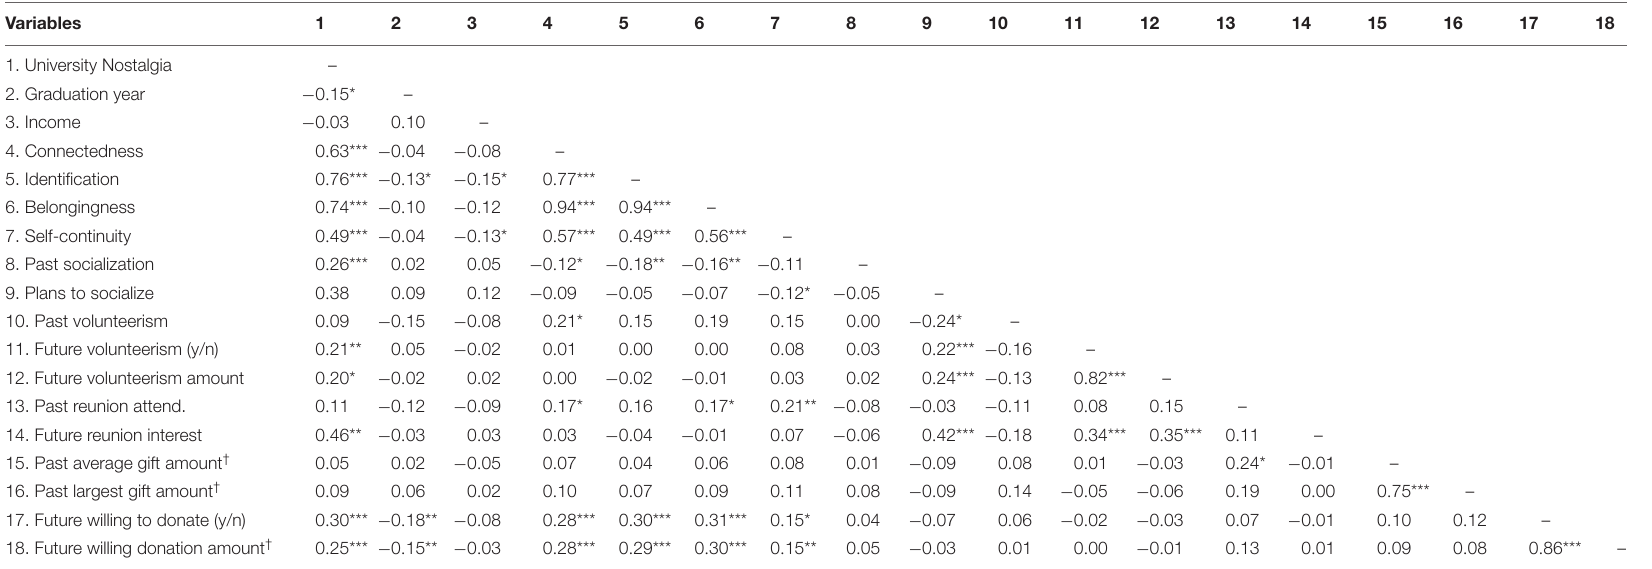
TABLE 2 | Descriptive statistics and bivariate correlations among study 1 variables ( N = 310).